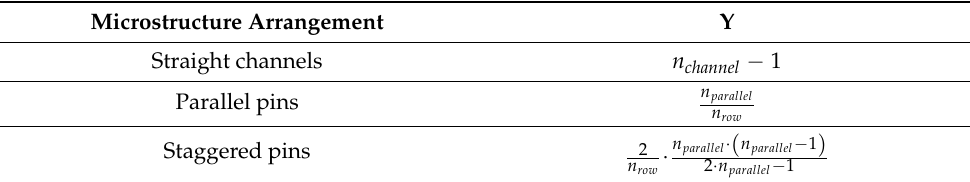
Table 3. Parameter Y depending on the microstructured arrangement for the calculation of the thermal resistance to axial heat